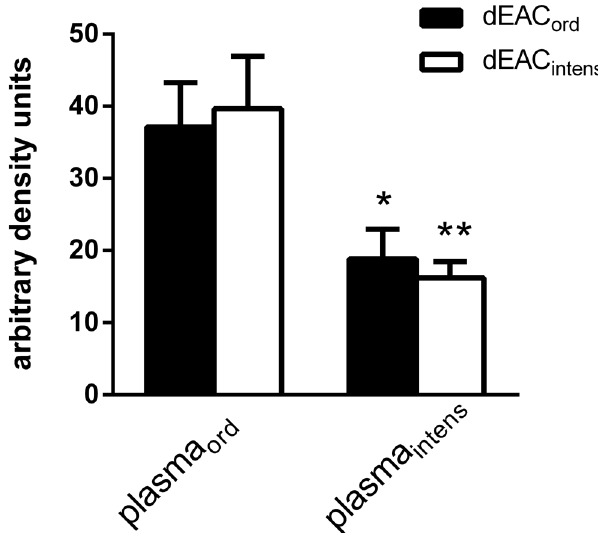
Figure 7. Quantification of specific antibodies in mouse plasma after immunization with dEAC ord (plasma ord ) and dEAC intens (plasma intens ). On the western blots as described in Fig. 4, the 140 and the 240 kDa bands of the dEAC ord extracts (n=7) and of the dEAC intens extracts (n=9) probed with the respective plasma were quantified densitometrically. Shown are th means 6 SEM. *: p , 0.05 and **: p , 0.01 between plasma ord and plasma intens by Student’s t-test (plasma in- tens ) or Mann-Whitney U test (plasma ord ).